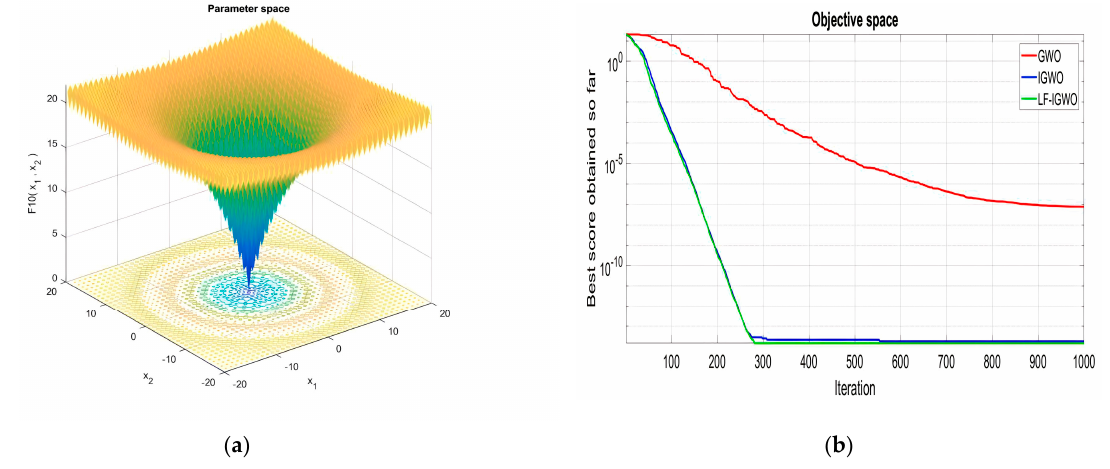
Figure 12. ( a ) Search space for multi model function F10 ( b ) Comparison of convergence curve for F10.